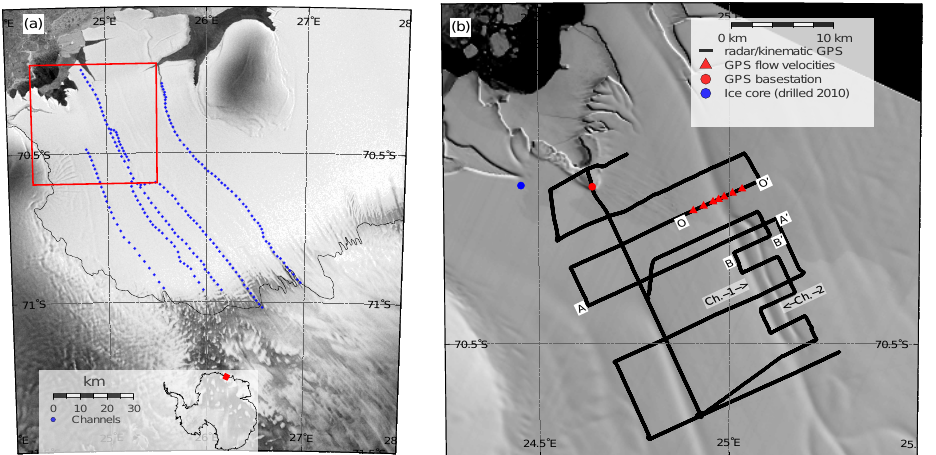
Figure 1. Overview of the Roi Baudouin Ice Shelf, Dronning Maud Land, Antarctica: (a) ice-shelf channels start near the grounding line and extend into the ice shelf (marked with blue dots in the Radarsat Mosaic, Jezek and RAMP-Product-Team, 2002). The red box marks the close-up in (b) locating radar/GPS profiles of the surveys. Channels (e.g., Ch.-1, Ch.-2) appear in the background image (Landsat 8 in December 2013) as elongated